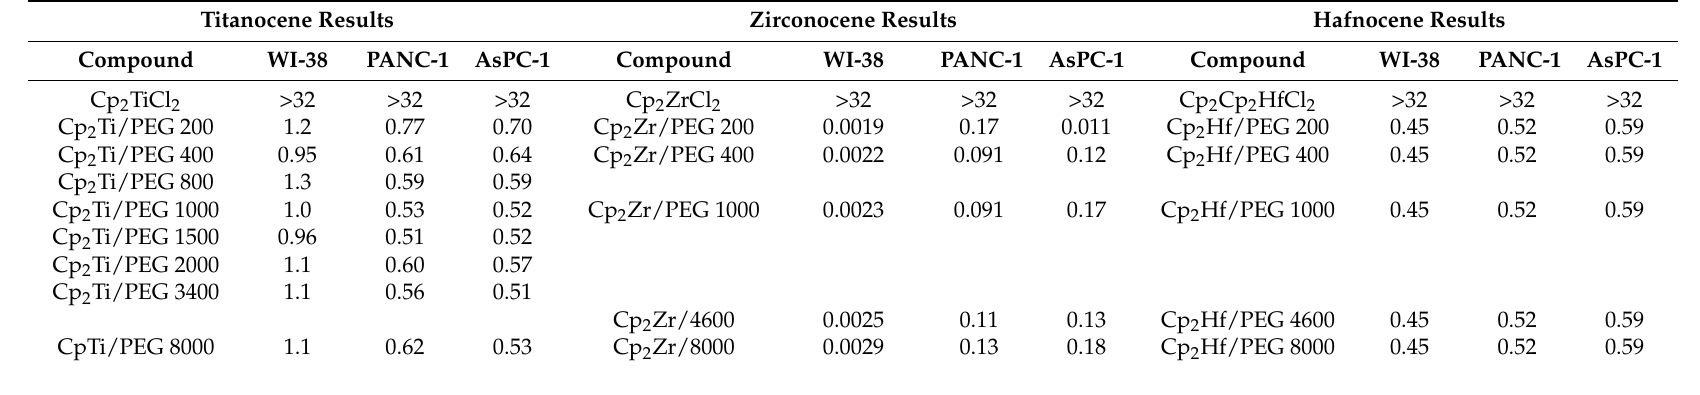
Table 6. EC 50 results (micrograms/mL) for the water-soluble metallocene polyethers as a function of metallocene, metallocene/PEG polymer, and pancreatic cancer cell line. Reaction conditions were as follows: an aqueous solution containing PEG (0.00100 mole) and sodium hydroxide (0.00200) dissolved in 50 mL of water is added to a rapidly stirred (about 18,000 rpm) chloroform (50 mL) solution containing the metallocene dichloride (0.00100 mole). Stirring continued for 15 s at room temperature (about 28 ◦ C)(EC: effective